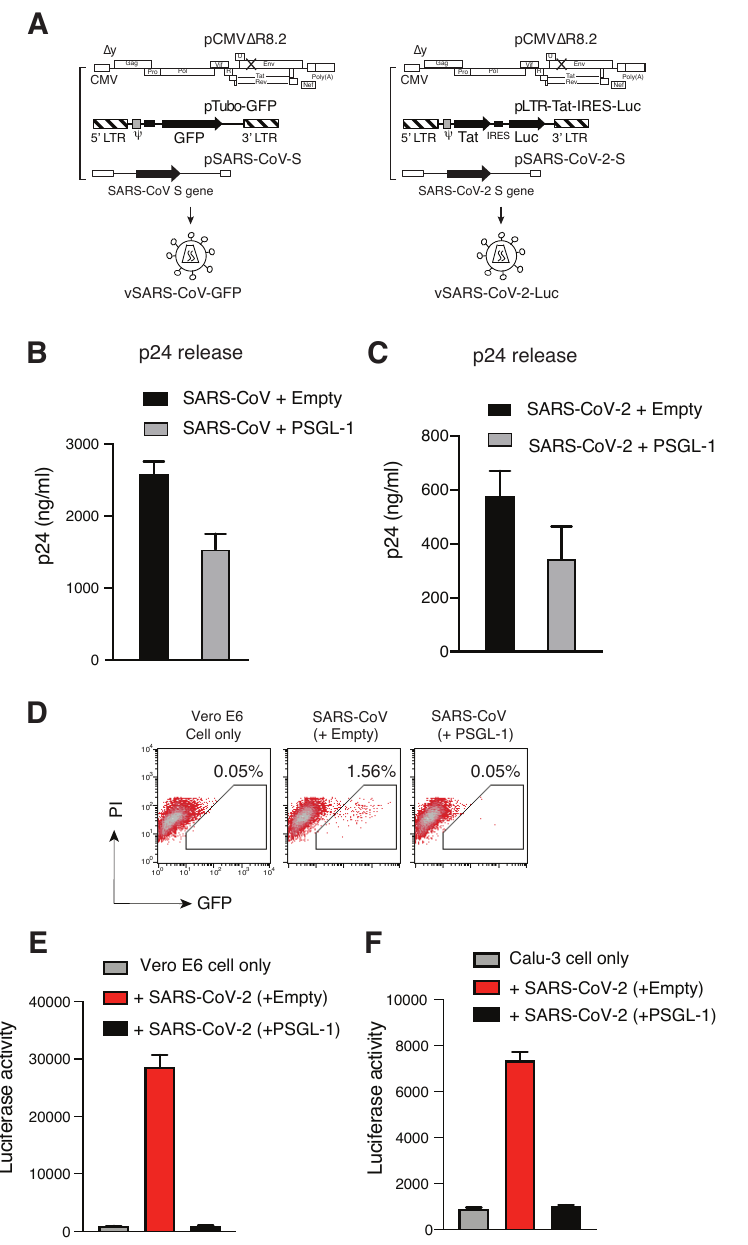
Figure 1. P-selectin glycoprotein ligand-1 (PSGL-1) inactivates the infectivity of SARS-CoV and SARS-CoV2 pseudoviruses. ( A ) Schematic of the assembly of lentiviral particles pseudotyped with the S proteins of SARS-CoV and SARS-CoV-2. ( B , C ) Effects of PSGL-1 on viral release. A PSGL-1 expression vector or control empty vector was co-transfected with the lentivirus packaging construct and a GFP or luciferase reporter plasmid, and viral release was quantified at 72 h post-transfection by HIV-1 p24 ELISA. ( D ) The infectivity of SARS-CoV pseudotyped virions was quantified by infecting Vero E6 cells and measuring GFP expression at 72 h post-infection. The percentages of GFP+ cells are shown. ( E , F ) The infectivity of the SARS-CoV-2 pseudotyped virions was quantified by infecting Vero E6 ( E ) and Calu-3 cells ( F ). Luciferase activity in infected cells was quantified at 72 h